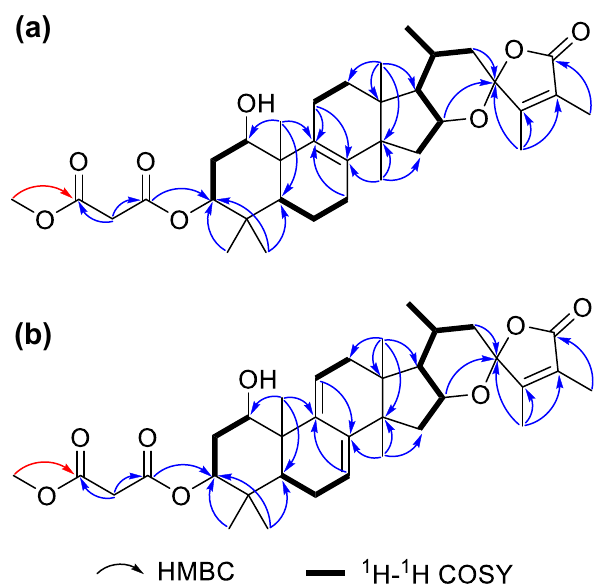
Fig. 2 Characteristic mutual HMBC (blue arrow) and 1 H– 1 H COSY correlations for a compounds 1 and 2 (HMBC in red arrow was exclusive for 2 ) and b compounds 3 and 4 (HMBC in red arrow was exclusive for 4 )